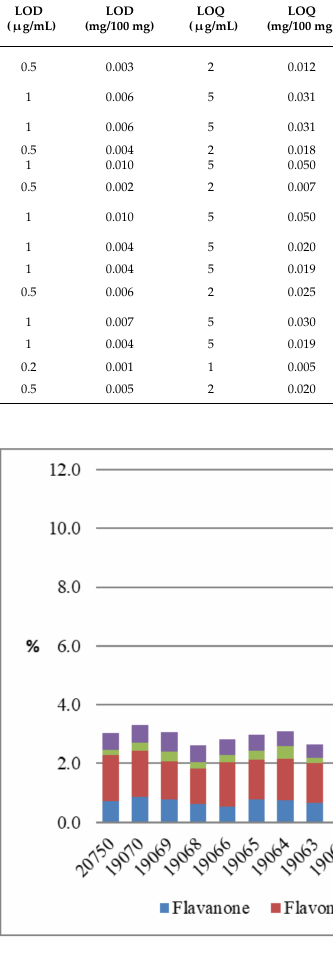
Figure 3. Quantitative analysis of flavonoids ( 2 – 14 ) in authenticated plant sample (#16850) and dietary supplements (green rooibos tea #19067), and red rooibos tea (#19051, #19052, #19053, #19054, #19055, #19056, #19057, #19058, #19059, #19060, #19061, #19062, #19063, #19064, #19065, #19066, #19068, #19069, #19070, and #20750) at 288 nm. The results are expressed as mg/100 mg of plant material and arranged according to the flavonoids subclasses; flavanone (( S )-eriodictyol-6- C - β - D -glucopyranoside ( 2 ) and ( R )-eriodictyol-6- C - β - D -glucopyranoside ( 3 )), flavone (isoorientin ( 4 ), orientin ( 5 ), vitexin ( 7 ), and isovitexin ( 10 )), dihydrochalcone (aspalathin ( 6 ) and nothofagin ( 13 )), flavonol (bioquercetin ( 8 ), hyperoside ( 9 ), rutin ( 11 ), isoquercitrin ( 12 ), and thermopsoside ( 14